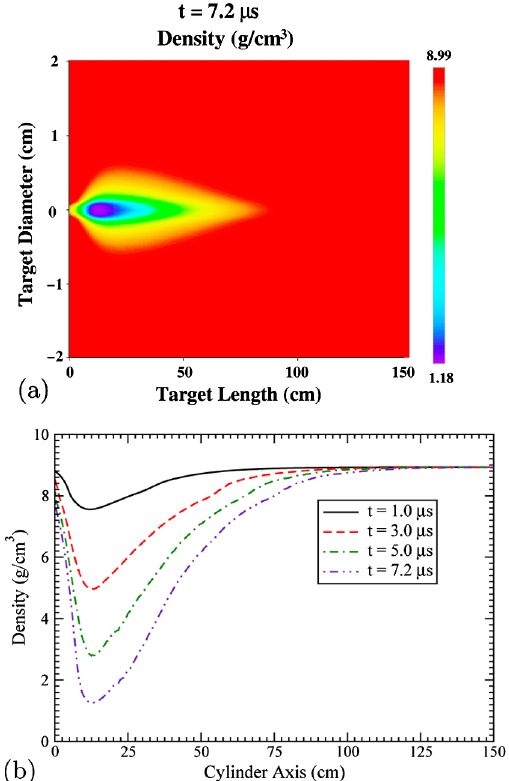
FIG. 14. (a) Density distribution in the cylindrical copper target, r ¼ 5 cm , L ¼ 1 : 5 m , irradiated by the 440 GeV SPS proton beam with (cid:1) ¼ 0 : 5 mm at t ¼ 7 : 2 (cid:2) s (end of the beam) and (b) density profiles along the axis at different